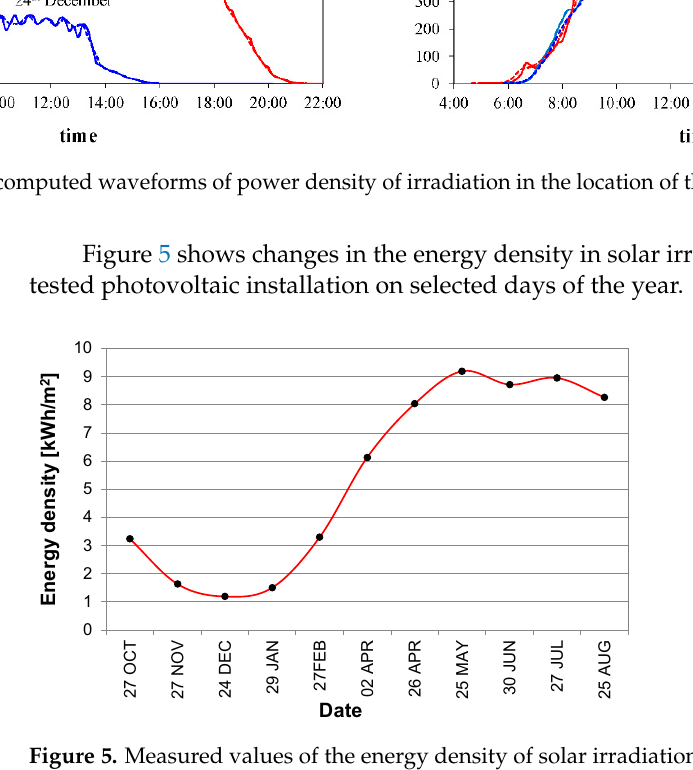
Figure 5. Measured values of the energy density of solar irradiation on selected days .